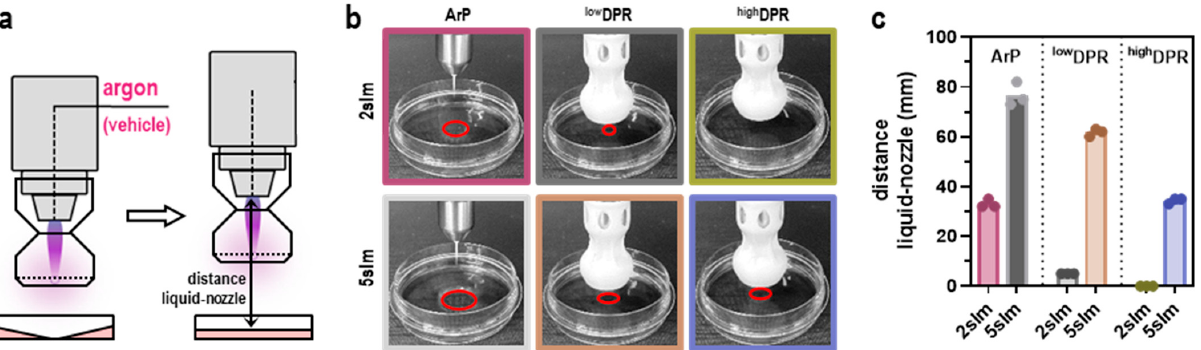
Figure 2. Medical gas plasma jet kINPen and MoNoS adapters. ( a ) schematic overview of gas plasma treatment using the MoNoS adapters; ( b ) representative images of gas plasma treatment without (ArP) and with DPR (red circles indicate the region of volume displacement); ( c ) closest possible distance of liquid to the nozzle (without liquid spillage) measured at different gas flow rates and with different adapters. Bar graphs show mean and individual values. slm = standard liters per minute; ArP = argon plasma (typical setup without adapter); low DPR = low dynamic pressure reduction; high DPR = high dynamic pressure reduction.